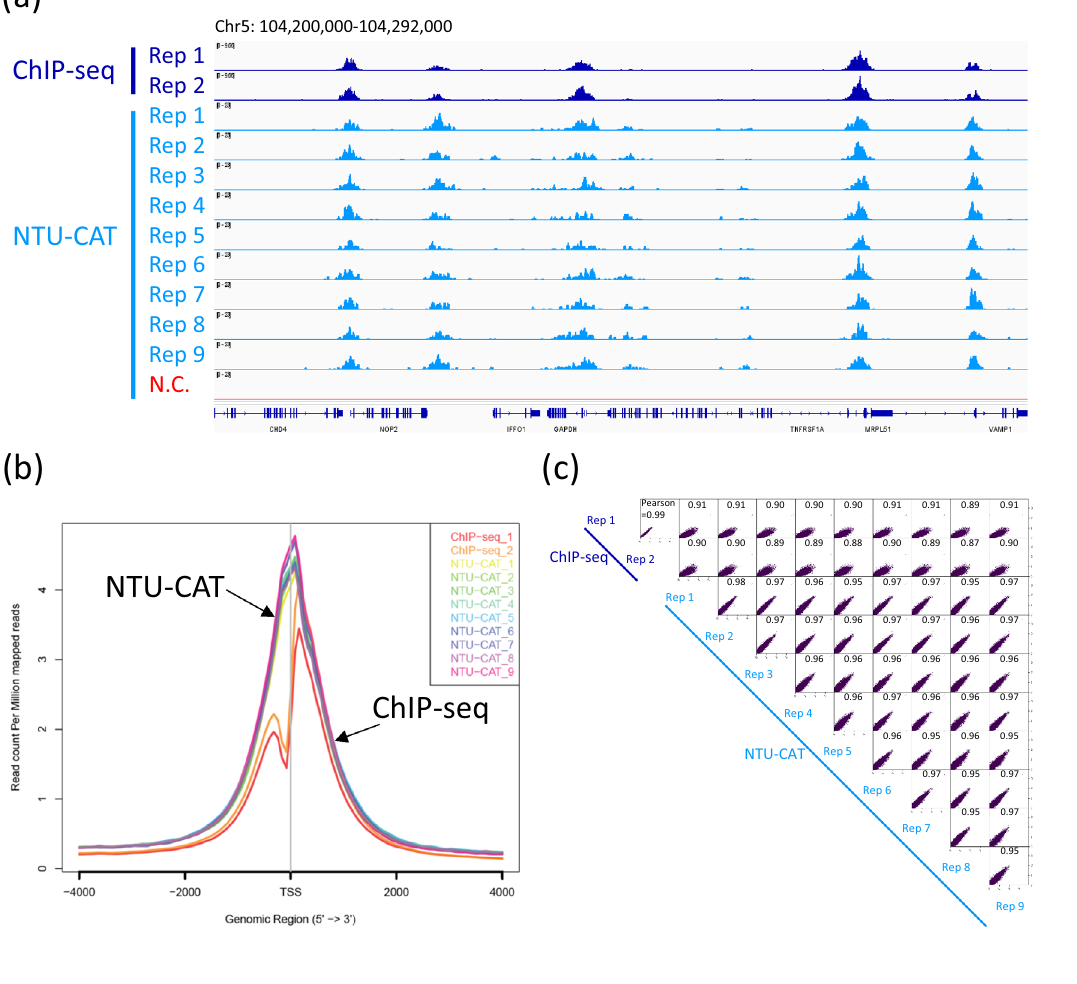
Figure 2. Comparison of NTU-CAT and ChIP-seq results for H3K4me3 in bovine blastocysts. ( a ) Snapshot of the H3K4me3 landscape in a 92-kb region (chromosome 5) that includes the GAPDH TSS. The NTU-CAT- derived peaks in nine replicates were visualized using Integrative Genomics Viewer 29 alongside the peaks from our previous ChIP-seq analysis of a cohort of blastocysts 11 . N.C. is the negative control in which the primary antibody was omitted from the NTU-CAT procedure. ( b ) Average profile plot of the H3K4me3 signal around genome-wide TSSs. The signals from the nine replicates of NTU-CAT and duplicates of ChIP-seq 11 are shown. The average profile plots were generated by ngs.plot 28 . ( c ) Correlation analysis of duplicates of ChIP-seq and nine replicates of NTU-CAT for H3K4me3 in bovine blastocysts. Scatterplots of these pairwise comparisons are shown with Pearson correlation coefficients. Bin sizes of 10 kb and natural log transformation after adding 1 were used for drawing with deepTools (https:// deept ools. readt hedocs. io/ en/ devel